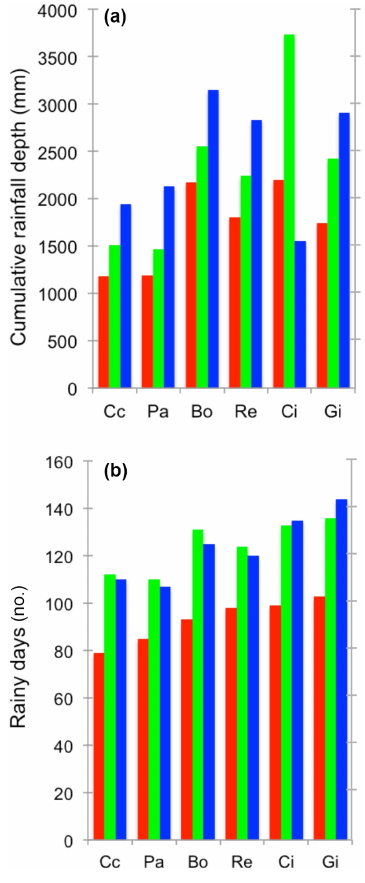
Figure 5. Comparison of (a) the total (cumulated) rainfall, and (b) the mean number of rainy days, in the 15-year period 2002–2016 (blue), in 2013 (red) and in 2014 (green), at selected rain gauges in the Entella catchment. Rain gauges: Cc – Chiavari; Gi – Giacopiane Lago; Re – Reppia, Pa – Panesi; Ci – Cichero, Bo – Borzone. See Fig. 1 for the location of the rain